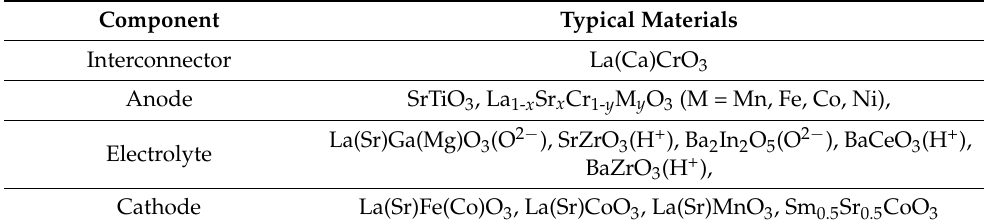
Figure 7. Band diagram of a hydrogen electrode-based alkali tantalates ATaO 3 (A = W Li, Na, and K) band structures with perovskite-type structures. Adapted from Ref. [43]. Table 4. Appropriate perovskite oxide materials for use in SOFCs.